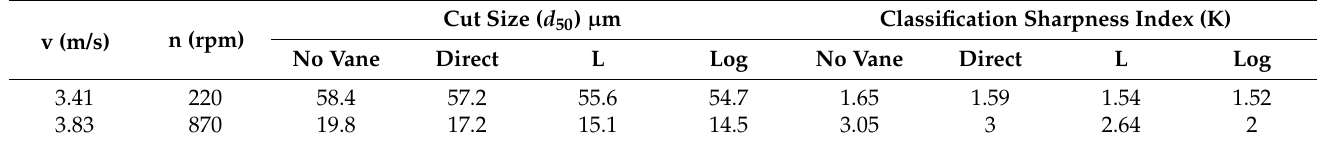
Table 2. The cut size and classification sharpness index for the different guide vane